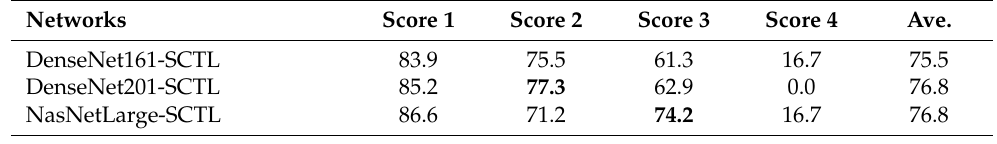
Table 3. Accuracy of each class in the test dataset. Shown in bold are the highest performance of a network for each score. Note that no single network achieves the highest accuracy for all scores.